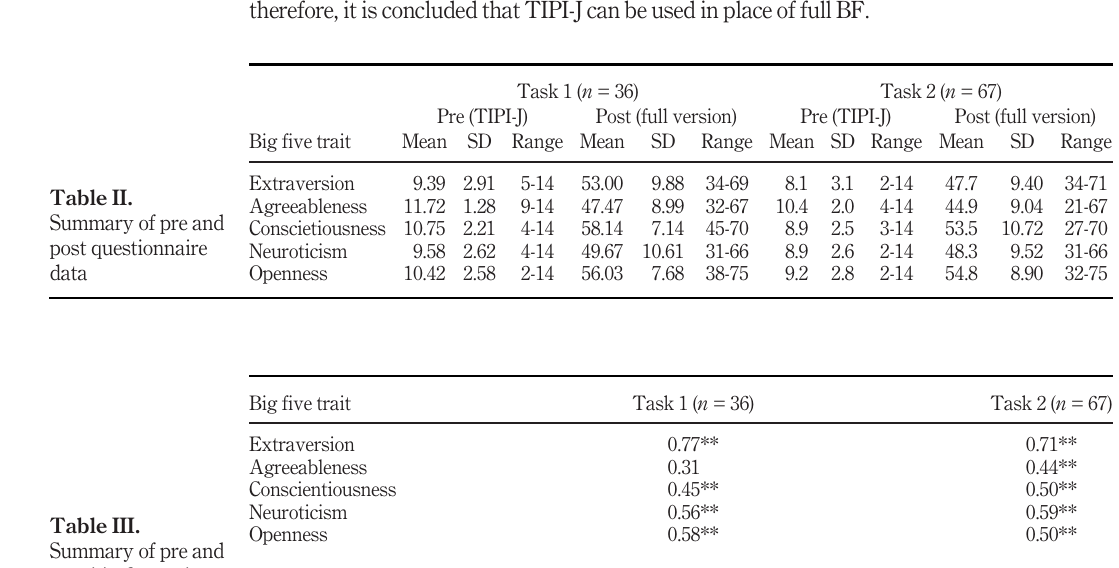
Table III. Summary of pre and post big fi ve trait